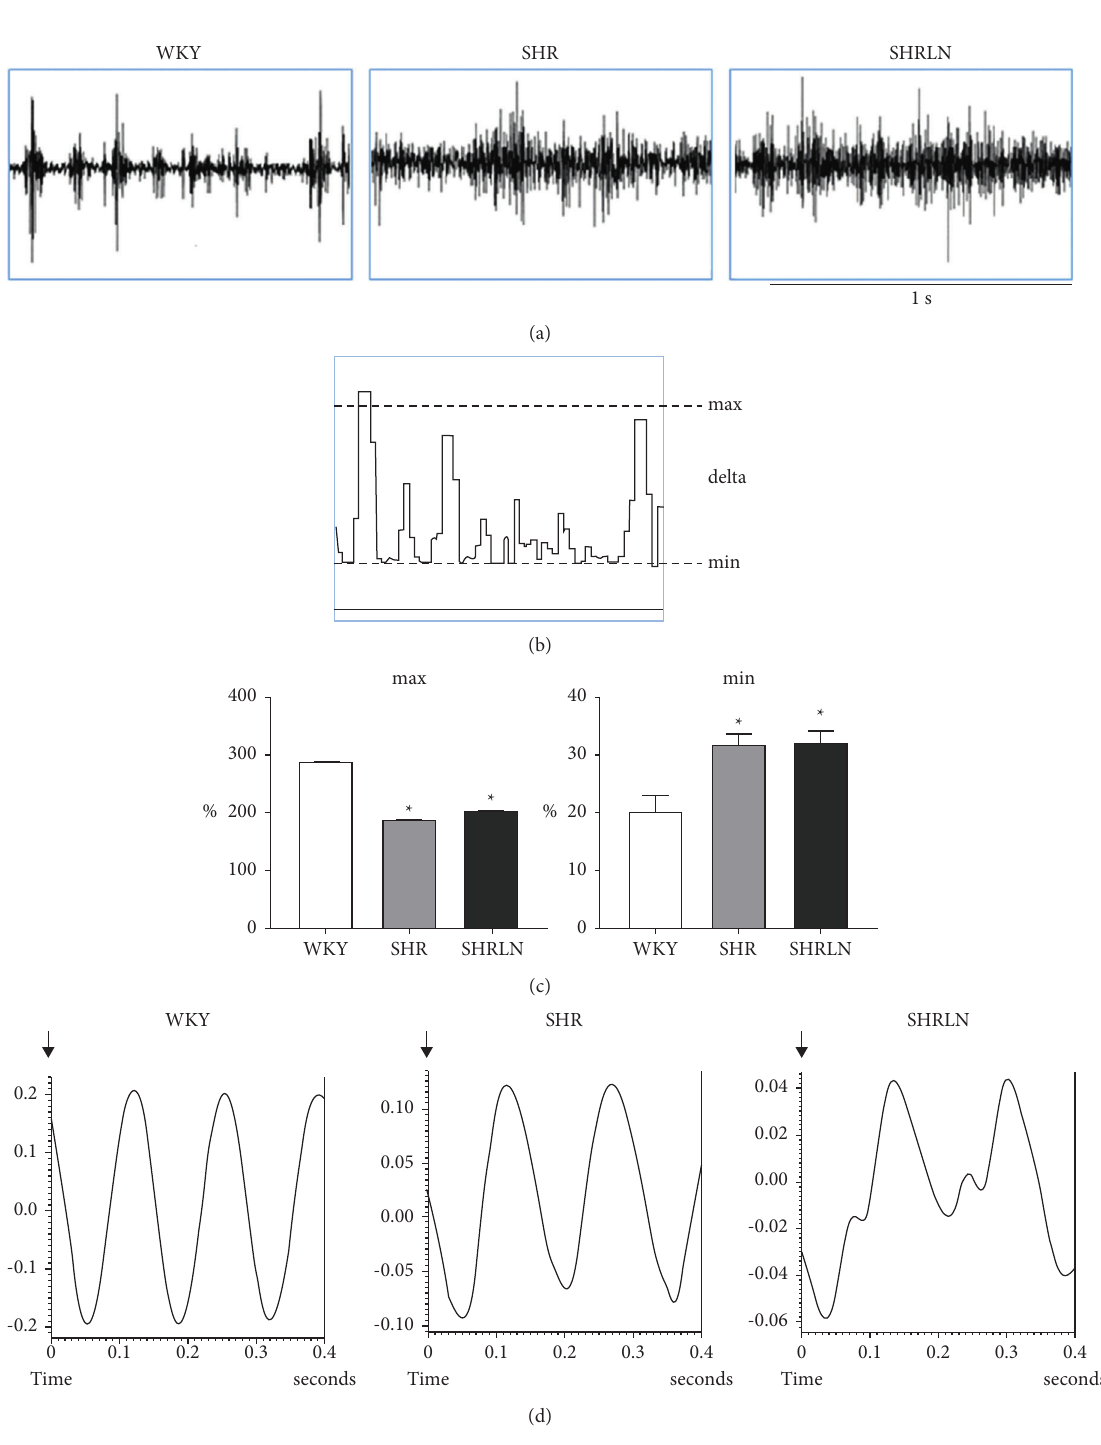
Figure 1: (a) Example of raw recordings of renal sympathetic nerve activity in normotensive WKY and hypertensive SHR and SHRLN. (b) Example of RNA recording for burst analysis, thus rectified and integrated in µ V/100ms. (c) RNA analysis of burst: the maximal value/mean RSNA representing maximal amplitude (max); the minimal value/mean RSNA. ∗ Significantly different from WKY (one-way ANOVA). (d) Examples of online analysis of the RSNA-HR temporal correlation; RSNA is cumulated over 400ms periods, triggered by systolic pressure. All examples shown are taken from our present